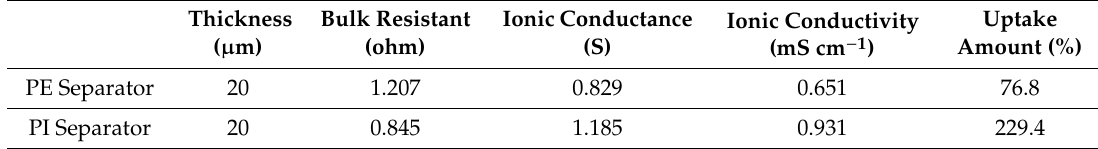
Table 1. Physical properties of bare PE separators and porous PI